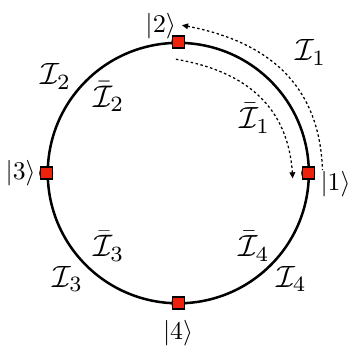
Figure 2 . T N model is quantum mechanics with periodic potential − cos( Nq ) on a circle with fundamental domain q ∈ [0 , 2 π ] . In the Born-Oppenheimer approximation, it is equivalent to N - site lattice model. In partition function, we sum only over periodic paths, corresponding to integer winding number topologies, but obviously, there are other saddles with fractional winding